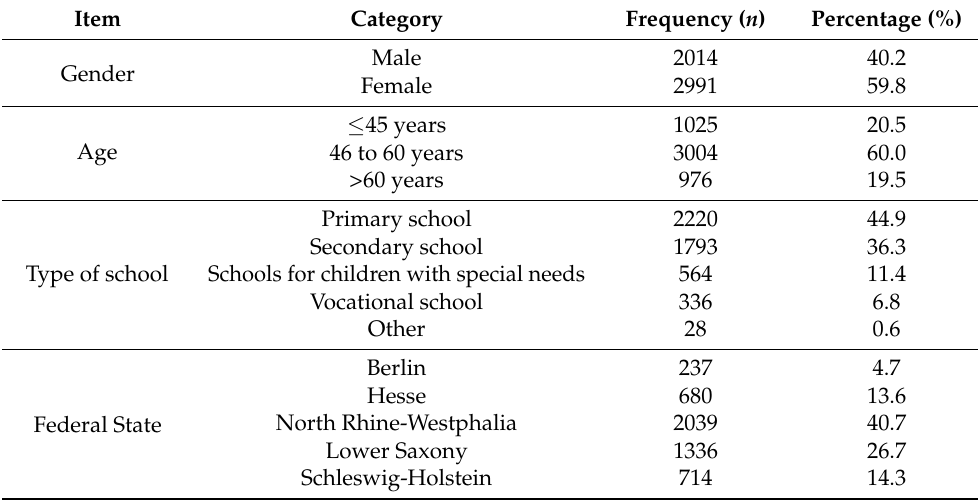
Table 1. Characteristics of study